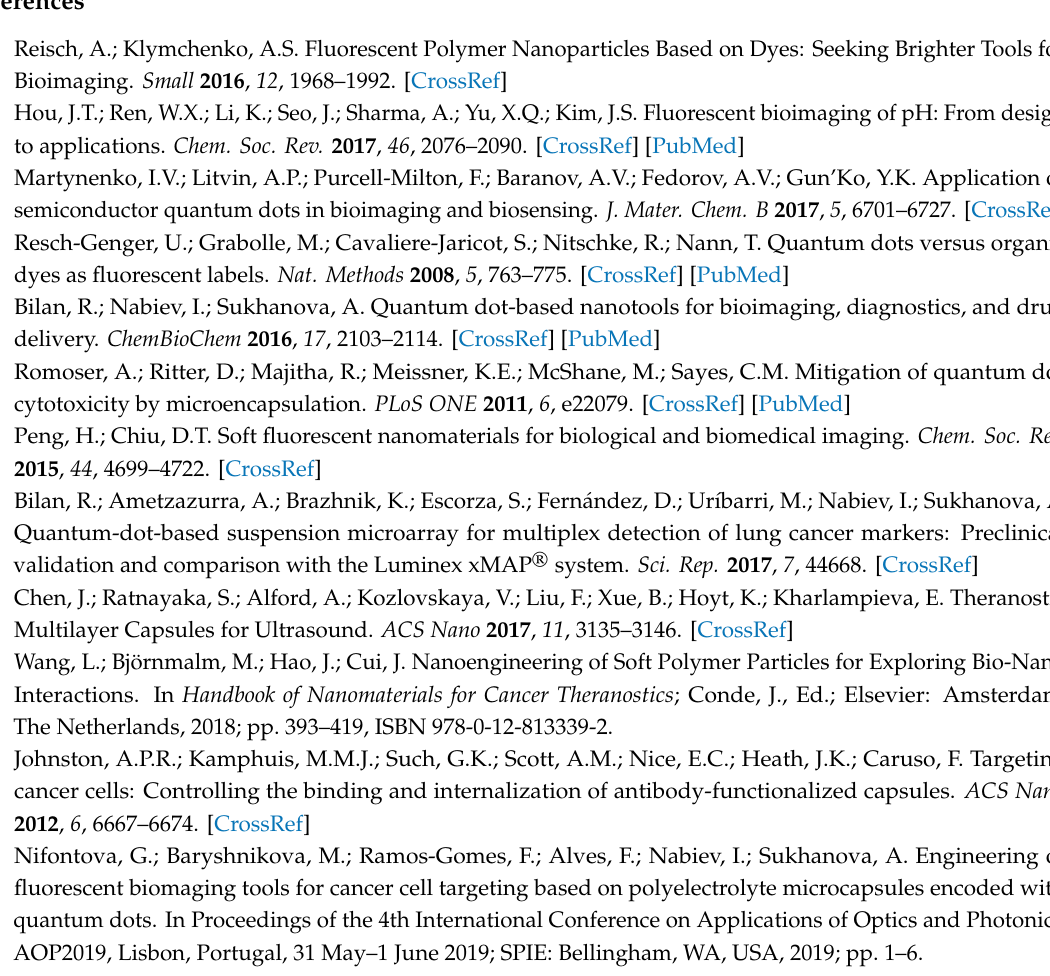
Figure S1: Quantum dot characteristics (absorption spectrum is shown in dashed line; fluorescence spectrum is shown in solid line; the data on QD hydrodynamic diameter distribution are presented in the